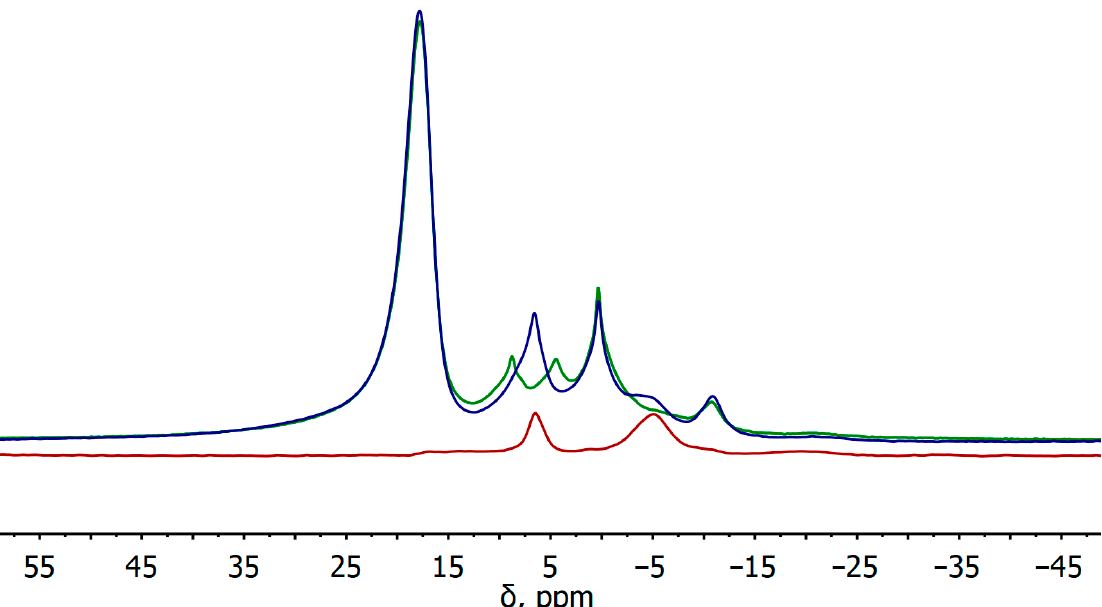
Figure 4. The 31 P (green line) and 31 P{ 1 H} (blue line) MAS NMR spectra and 1 H → 31 P CPMAS NMR spectrum (red line) of BP–CCl 2.